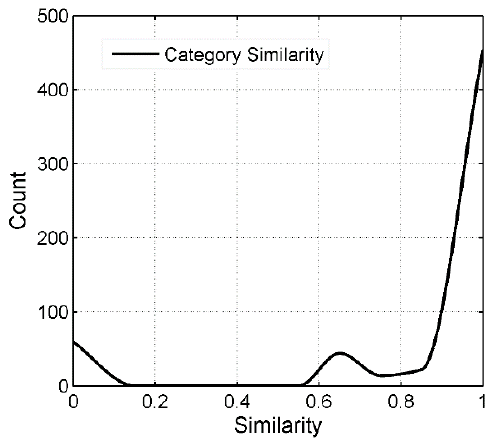
Figure 7. The category similarity attribute.